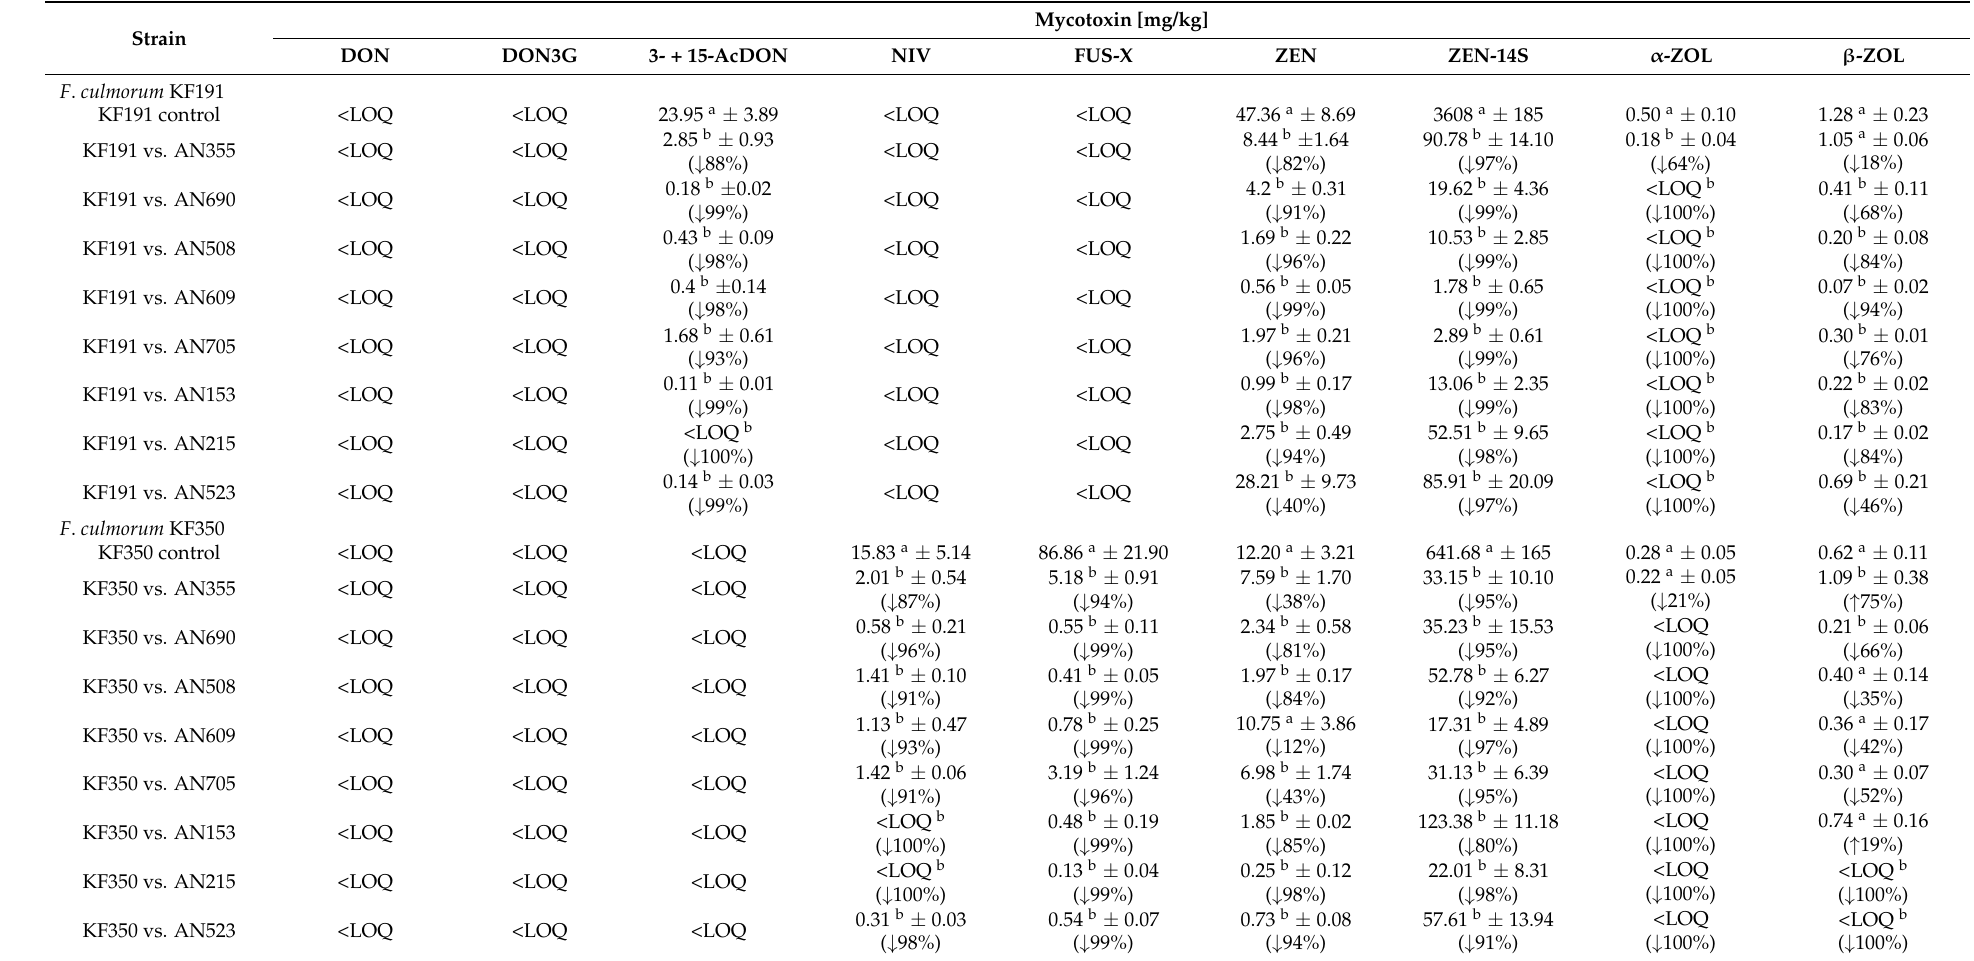
Table 3. Mycotoxin production (mg/kg) by Fusarium strains on solid substrates (rice kernels) in the presence/absence of the Trichoderma